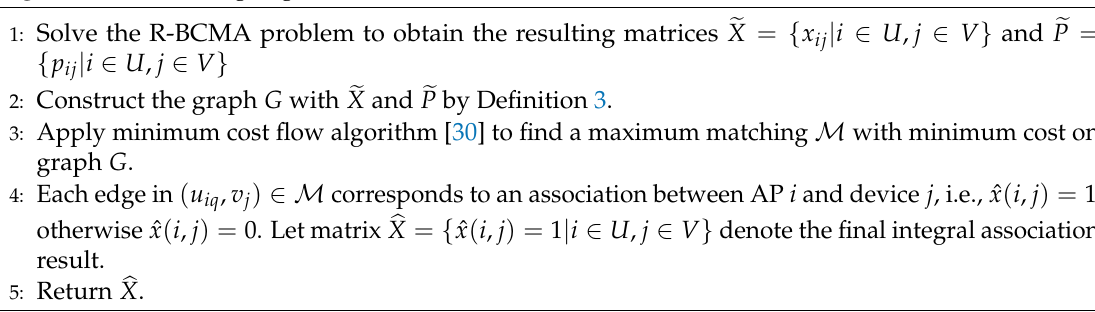
Algorithm 1 Rounding Algorithm for Association